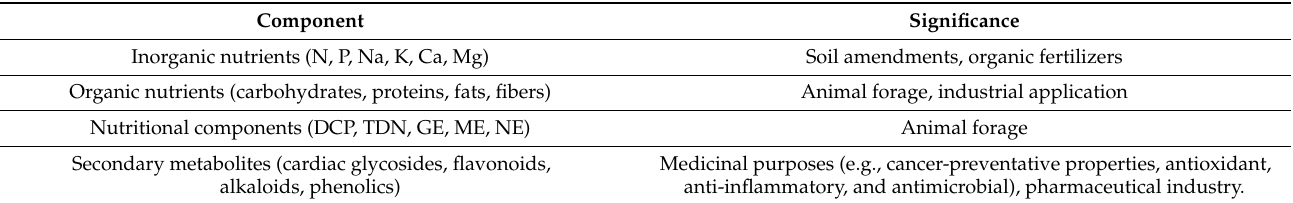
Table 5. Micro-components of the different organs of Taif’s rose and their significance.